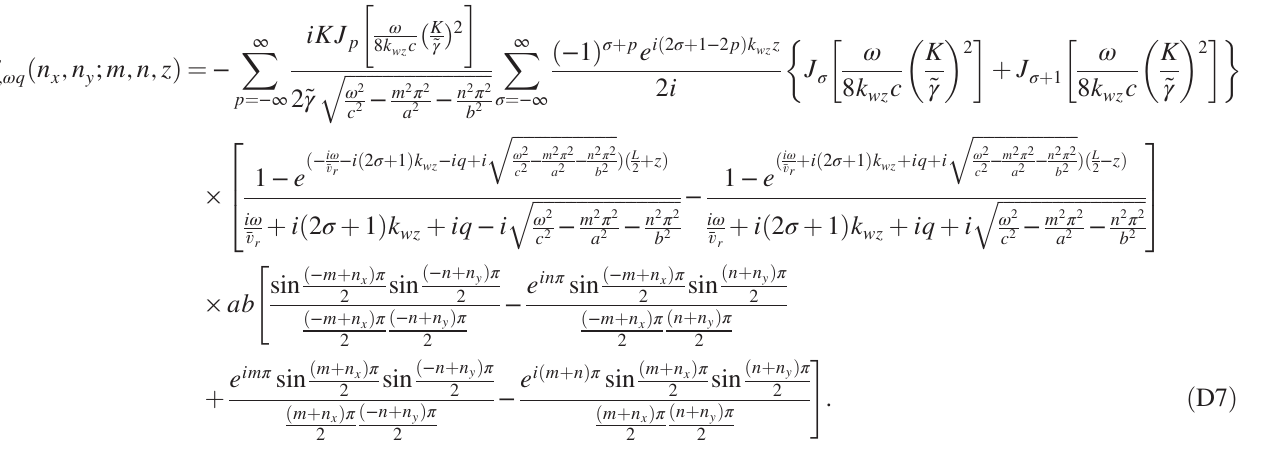
ffiffiffiffiffiffiffiffiffiffiffiffiffiffiffiffiffiffiffiffiffiffiffiffiffiffiffi